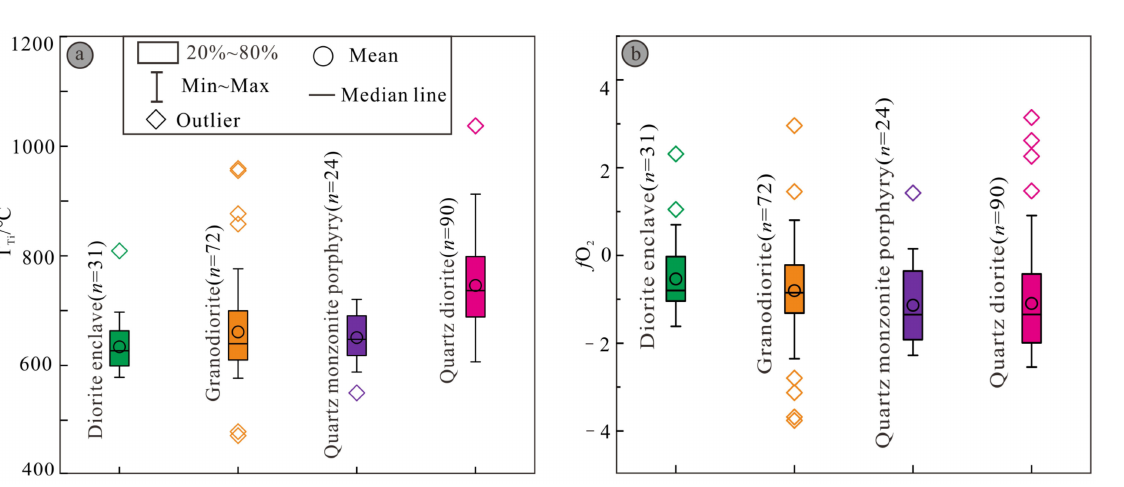
Figure 11. The zircons crystal temperature and oxygen fugacity diagram of Yangla granitoid plutons. ( a ) comparative box plots for the zircons crystal temperature and ( b ) oxygen